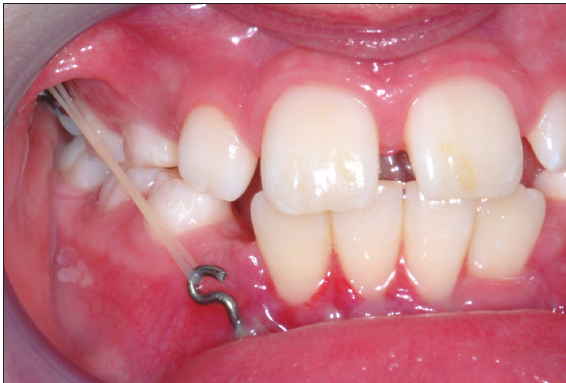
Figure 2. Class III intra-oral elastic forces as applied between the Hybrid Hyrax and Mentoplate arms bilaterally (Source: University of Düsseldorf,